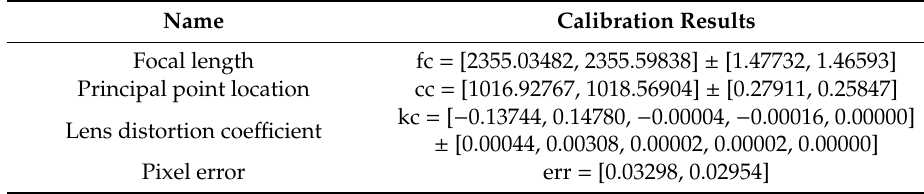
Table 1. Internal parameters of the